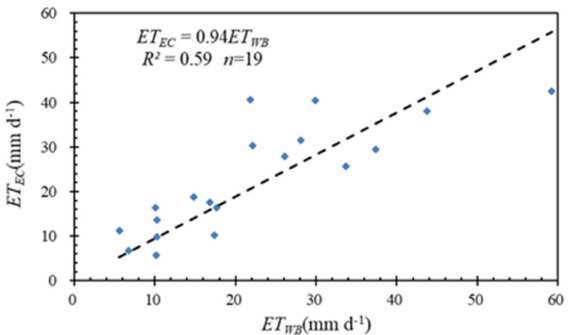
Figure 2. Comparison of weekly ET of Chinese cabbage from eddy covariance measurement and water balance method.